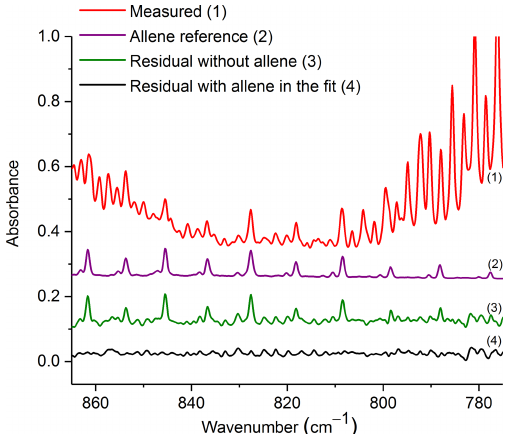
Figure 5. Measured absorbance spectrum and residuals with and without allene included in the fit, along with the scaled reference spectrum for allene. For clarity, the spectral contributions for C 2 H 2 , CO 2 , HCN, naphthalene, C 2 H 4 , methyl nitrite and H 2 O are not shown. All spectra are at 0.6cm − 1 resolution and have been offset for clarity. The calculated mixing ratio of allene in this measured spectrum is